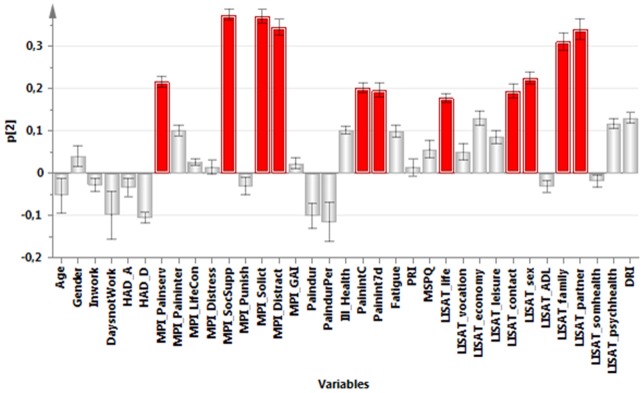
Variables with high absolute loadings on the second component (p2); high absolute loadings are marked in red.